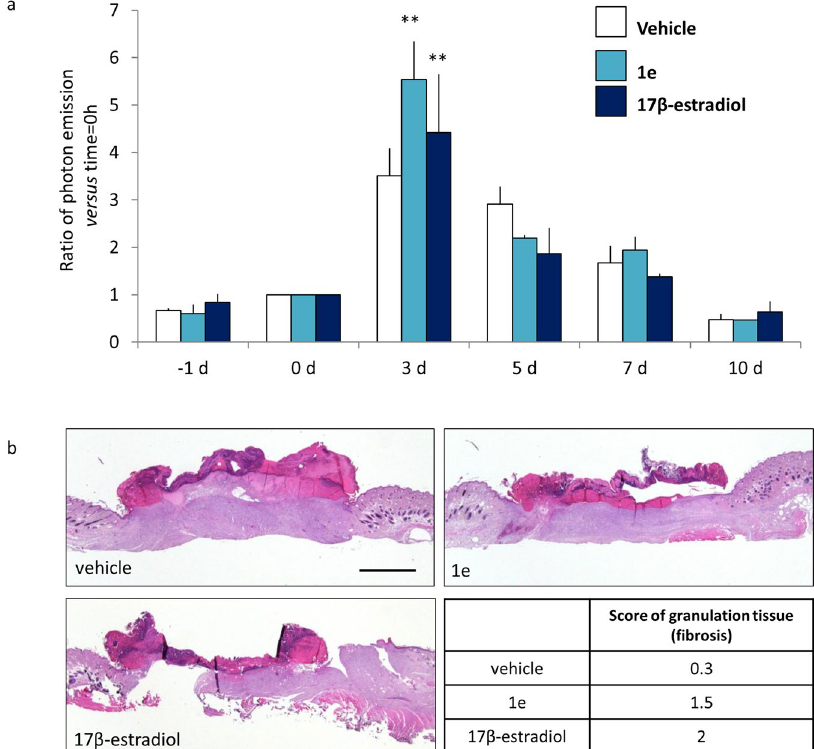
Figure 10. 1e compound and 17 β - estradiol accelerate wound healing. ( a ) In vivo BLI: round wound area photon emission quantification at indicated time point in MITO- Luc mice. Each bar represents the mean ratio versus time = 0 h + / − SEM of photon emission measured in 2 animals/group. ( ** p < 0.01 vs 0 h, ANOVA followed by Bonferroni’s test for multiple comparisons). ( b ) Hematoxylin-eosin representative staining of wound section at 10 days after the indicated treatments. The histoscore value for granulation tissue (fibrosis) is shown as mean, each histoscore consists of 4 random fields/groups, the criteria for the assignation of histoscore value are: 1 = wound bed partially covered with granulation tissue; 2 = thin granulation over the whole wound bed; 3 = thick granulation over the whole wound bed. Bar = 2